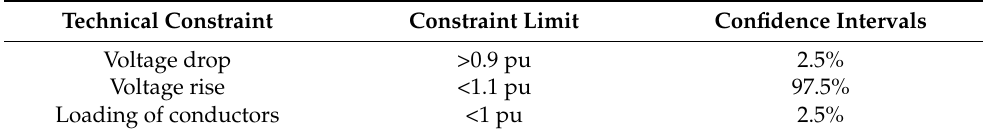
Table 1. Technical design